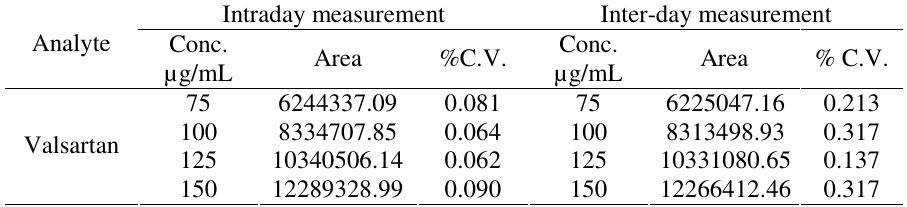
Table 3. Precision data of the proposed method (*n=5).